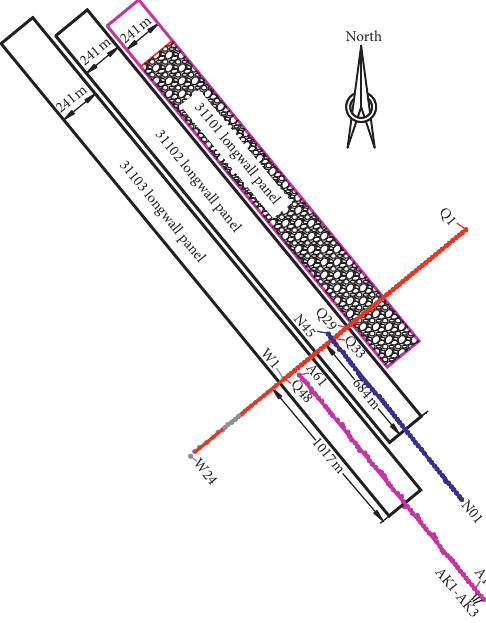
Figure 4: Monitoring lines above the panels. Table 1: Detailed information about the monitoring lines.